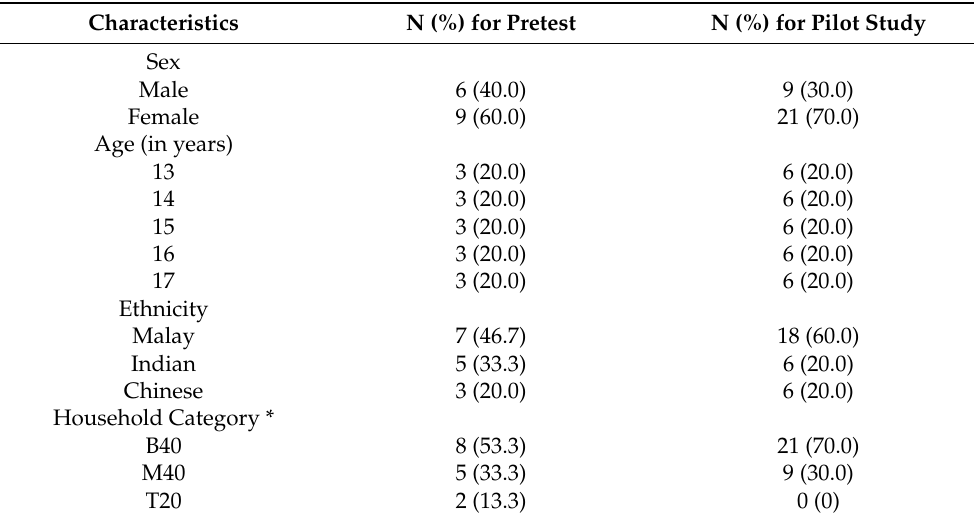
Table 1. Participants’ sociodemographic characteristics (N = 15 in the pre-test group phase 1 and 30 in the pilot study group phase